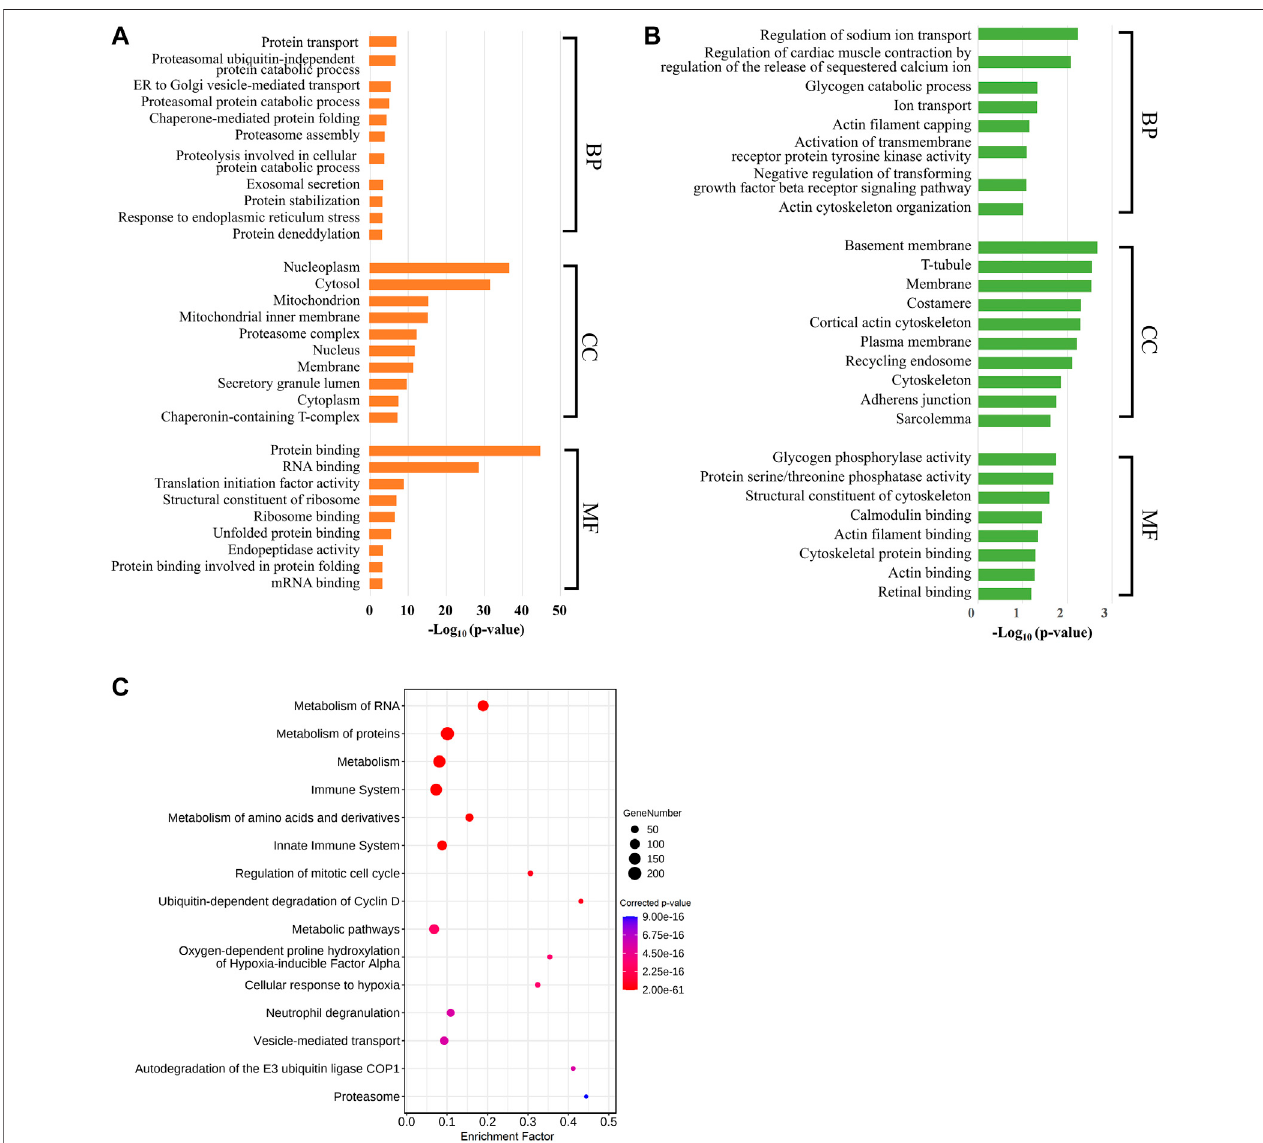
FIGURE 2 | Labor duration – correlated mRNAs function annotation. (A) Bar diagram of partial GO term clusters of positively correlated labor duration mRNAs. (B) Bar diagram of partial GO term clusters of negatively correlated labor duration mRNAs. (C) Bubble diagram of signi fi cantly enriched pathways for labor duration – correlated